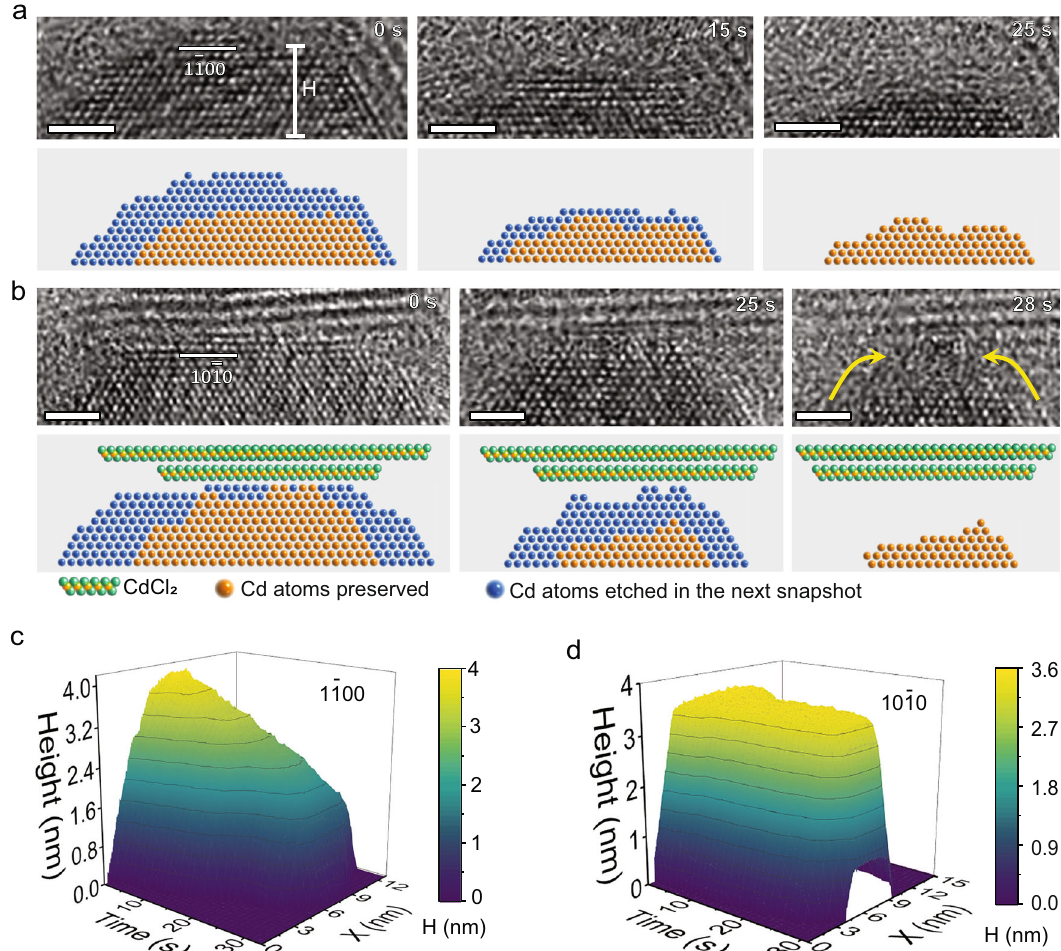
Fig. 3 In fl uence of the CdCl 2 shell on the dissolution of the Cd core. a HRTEM images from Supplementary Movie 2 show the dissolution of Cd (1 (cid:1) 100) facet exposed to the liquid directly. Without the protection of the shell, the atoms can be dissolved in all directions. b HRTEM images from Supplementary Movie 3 show the dissolution of Cd (10 (cid:1) 10) facet with a coated shell. Under the protection of the shell, the atoms dissolve mainly from the side. The corresponding atom models are shown below highlight the dissolution of Cd. The green balls are Cl atoms, the orange balls indicate the core Cd atoms preserved and the blue balls indicate the core Cd atoms that are absent in the next snapshot. The yellow arrows point out the gap between core and shell. c Height of Cd over time in [1 (cid:1) 100] direction. d Height of Cd over time in the [10 (cid:1) 10] direction. In ( c ), ( d ), X represents each position at the bottom of the images. The height is measured as the vertical distance from the Cd surface to the bottom of the images, as marked in ( a ). Scale bar, 2